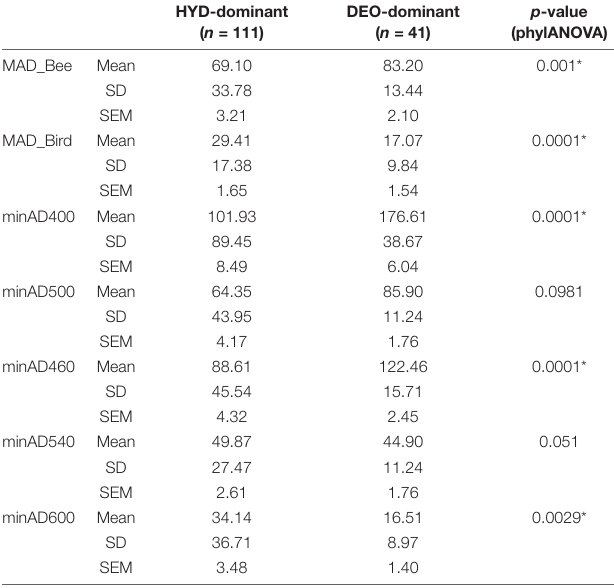
TABLE 1 | Statistical summary of MAD and minAD values for bee and hummingbird visual systems and their comparison between HYD-dominant ( > 50% HYD) and DEO-dominant ( > 50% DEO)